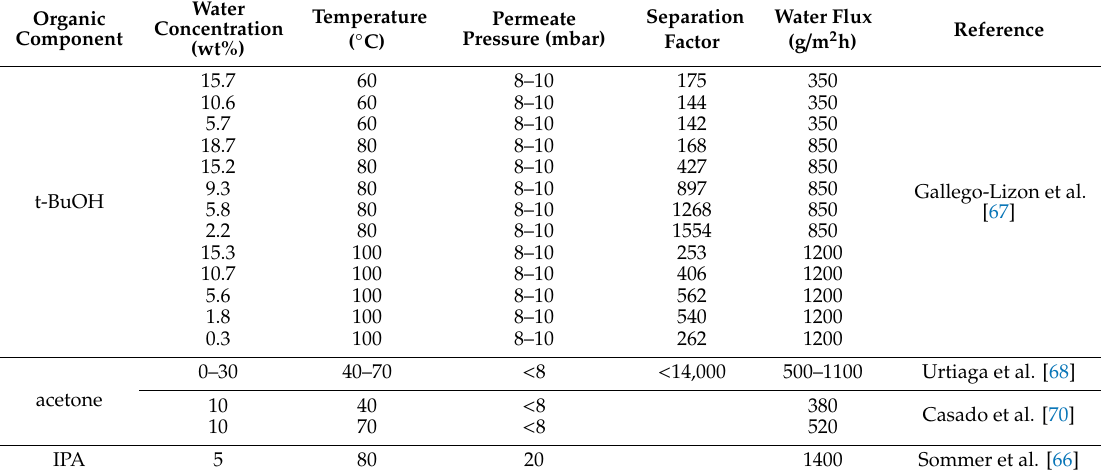
Table 4. Pervaporation performance for various solvents in their aqueous solutions, separation achieved using the commercial silica membrane, Pervap